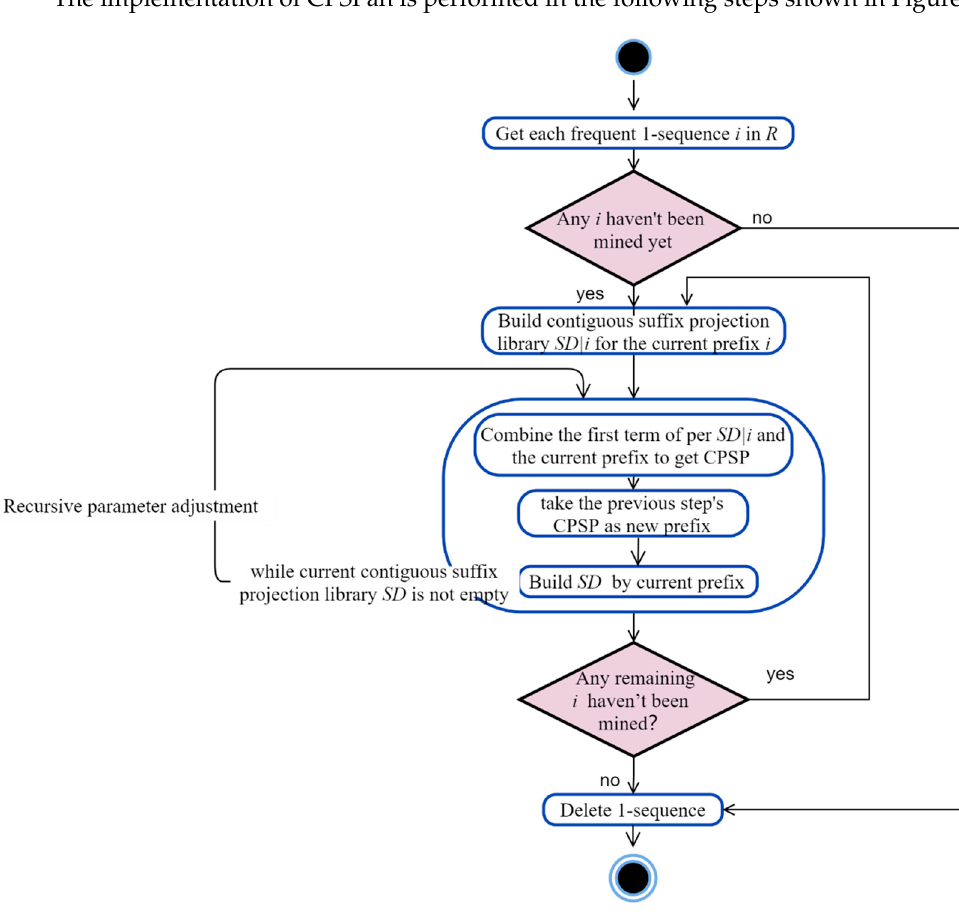
Figure 6. The CPSPan algorithm framework.